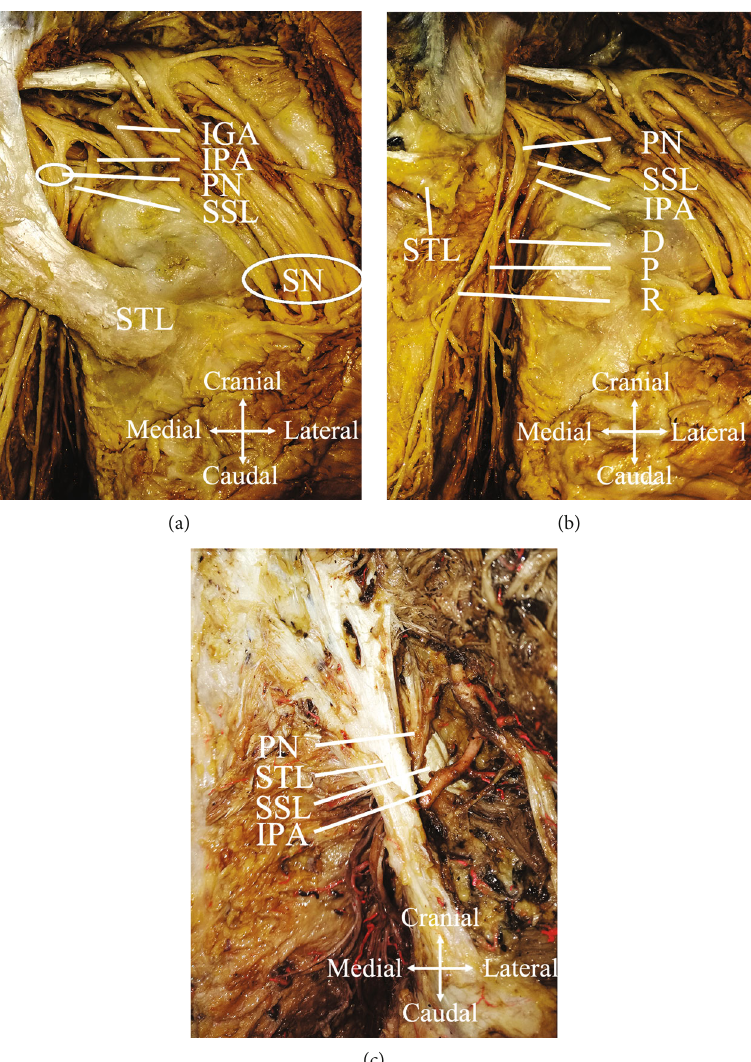
Figure 4: Anatomical study of the pudendal nerve in cadavers. (a) Pudendal nerve and its adjacent tissues. (b) Pudendal nerve and its branches of a male cadaver (dissection of the sacrotuberous ligament). (c) Pudendal nerve and its adjacent tissue in a female cadaver. STL: sacrotuberous ligament; SSL: sacrospinous ligament; IPA: internal pudendal artery; IGA: inferior gluteal artery; PN: pudendal nerve; SN: sciatic nerve; D: dorsal nerve of the penis; P: perineal nerve; R: inferior rectal nerve. Table 2: Distance of the pudendal nerve to the sciatic spine and the pudendal nerve to the internal pudendal artery in the cadavers. Distance between the Distance between the pudendal nerve and the pudendal nerve and the internal pudendal artery sciatic spine Male 13mm 6mm Female 11mm